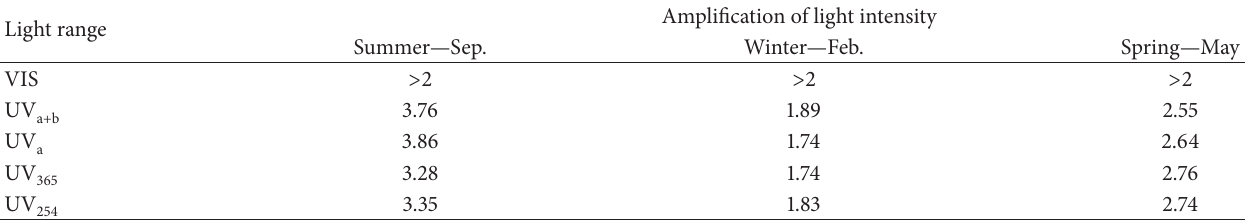
Table 3: Effect of Fresnel lens on the light amplification of IPCC in different seasons. Light range